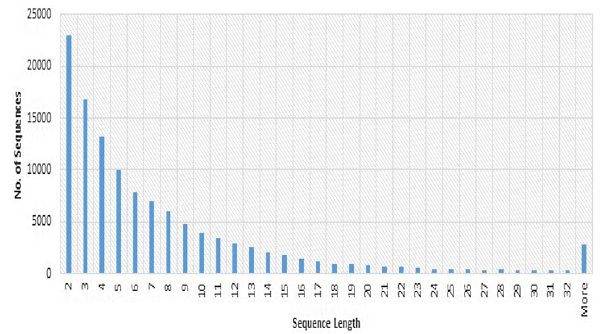
Fig. 1 Histogram for sequence lengths